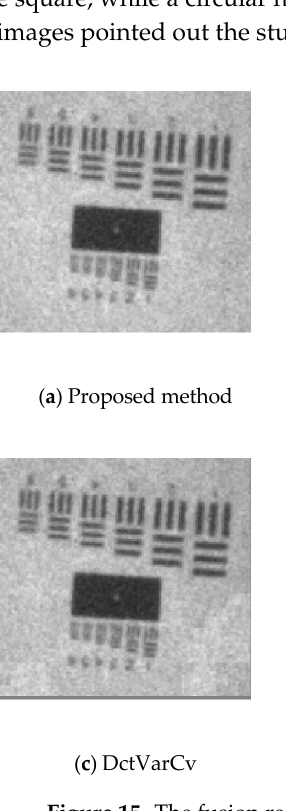
( d ) SAIF Figure 16. The fusion result of the NVG image (61 and 96 degrees).